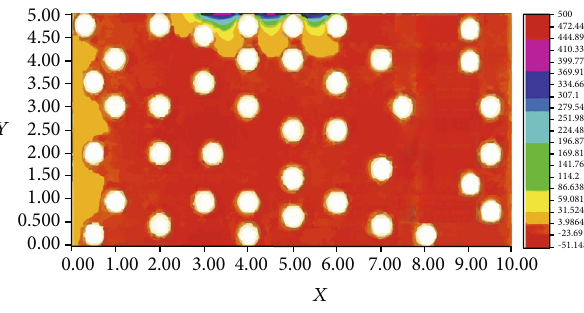
Figure 12: Concentration, D = 0 : 5 , C